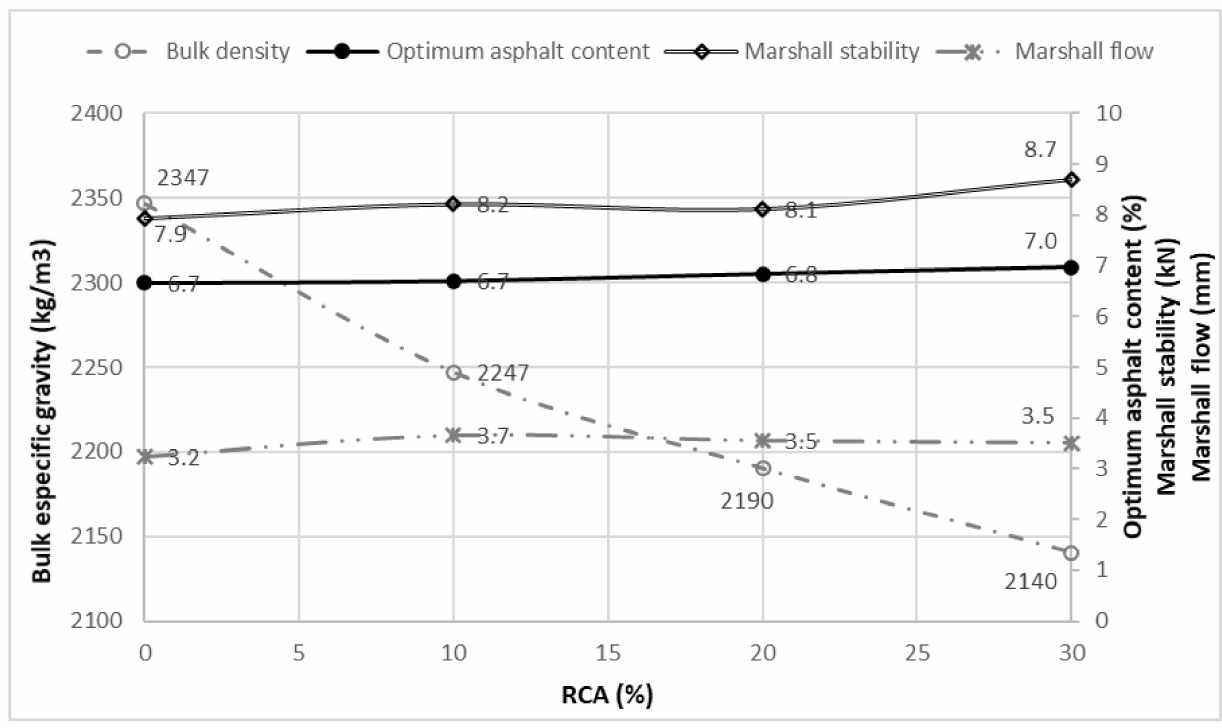
Figure 16. Correlation of bulk density versus optimum asphalt content, Marshall stability and Marshall